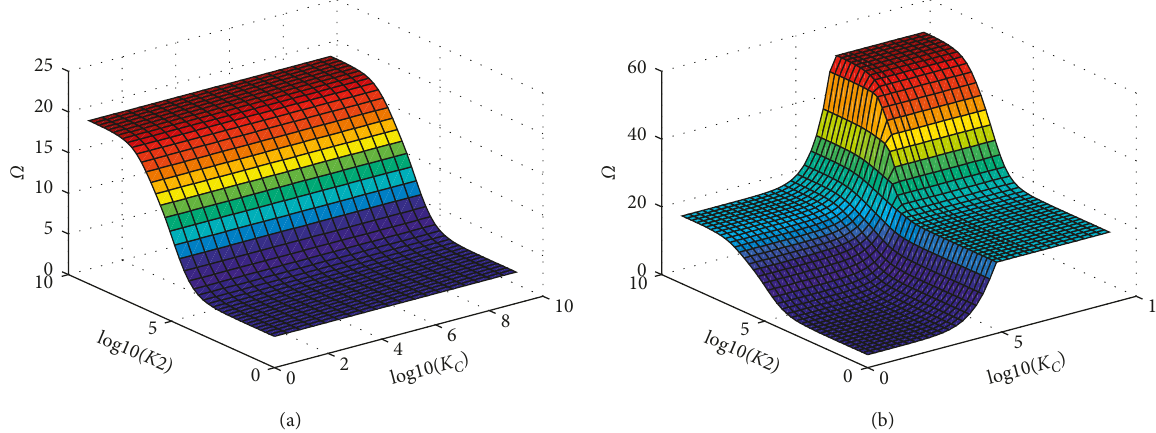
0 . 2 and r 2. (a) (cid:31) (cid:31)